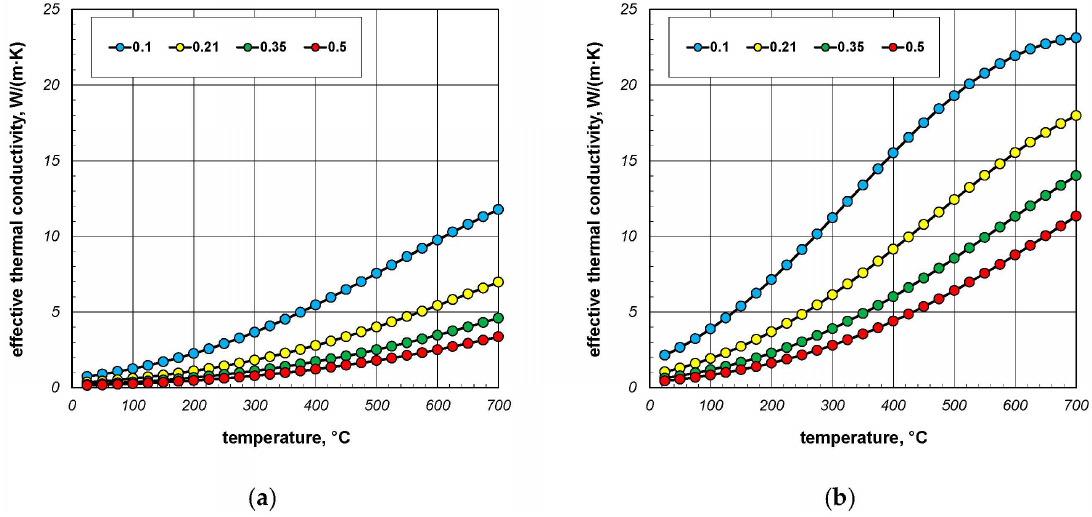
Figure 22. Calculated values of the effective thermal conductivity for a porous charge of a layered structure: ( a ) results for δ = 10 mm; ( b ) results for δ = 40 mm. The values visible in the key refer to the porosity of the